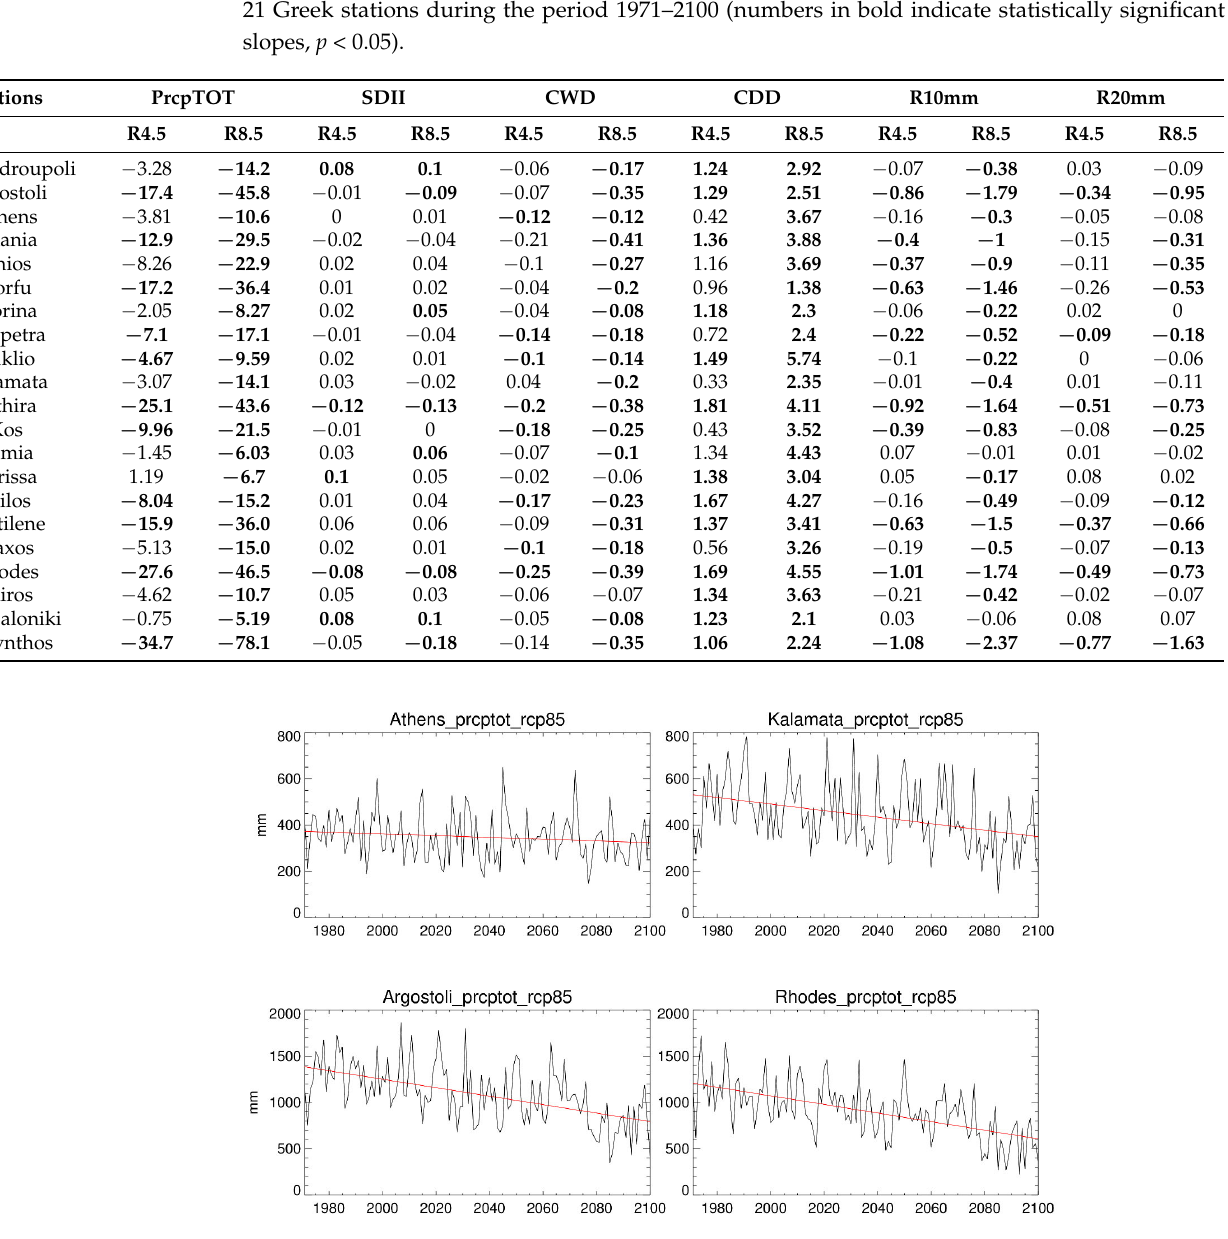
Figure 6. Annual sum of precipitation in wet days, where precipitation is at least 1 mm (PrcpTOT) during 1971–2100 in four Greek stations based on RCP8.5. Table 3. Decadal trends in annual extreme precipitation indices under RCP4.5 and RCP8.5 for 21 Greek stations during the period 1971–2100 (numbers in bold indicate statistically significant slopes, p < 0.05).